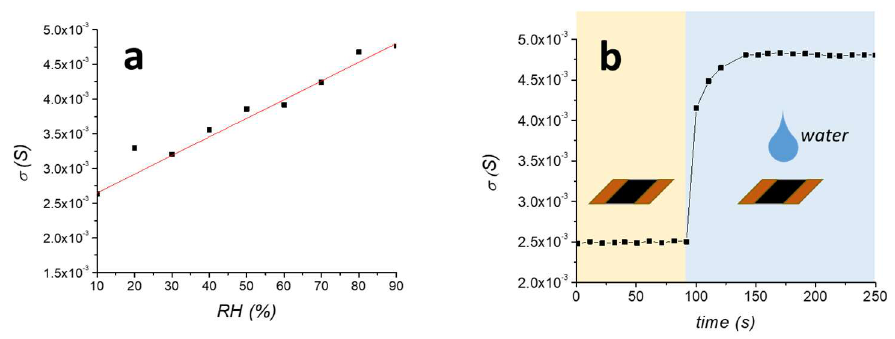
Figure 3. Surface conductivity of MMT/rGO film by progressively increasing the relative humidity ( a ) and by quick wetting of the dried film ( b ).